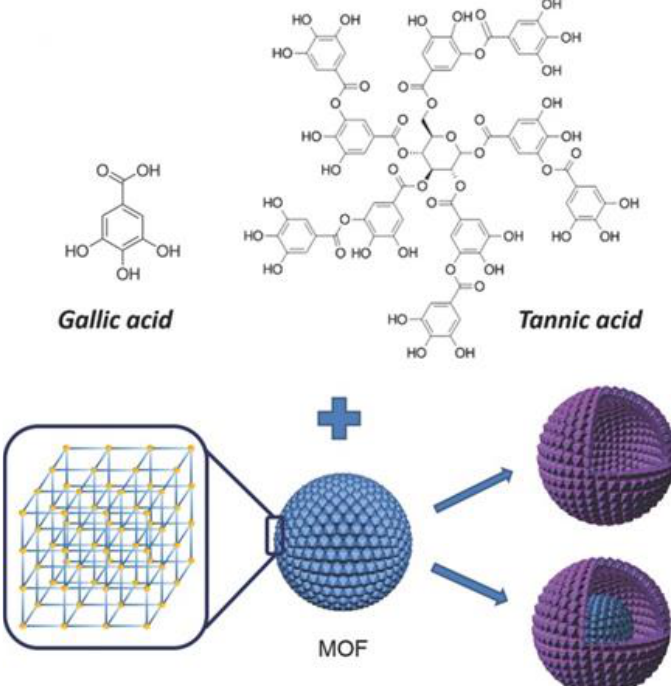
Figure 7. Schematic diagram of the synthesis of the structural formula of gallic acid and tannic acid, and the statement of the eroded process to construct the cavity. Reprinted with permission from Ref. [45]. Copyright 2016, WILEY-VCH Verlag